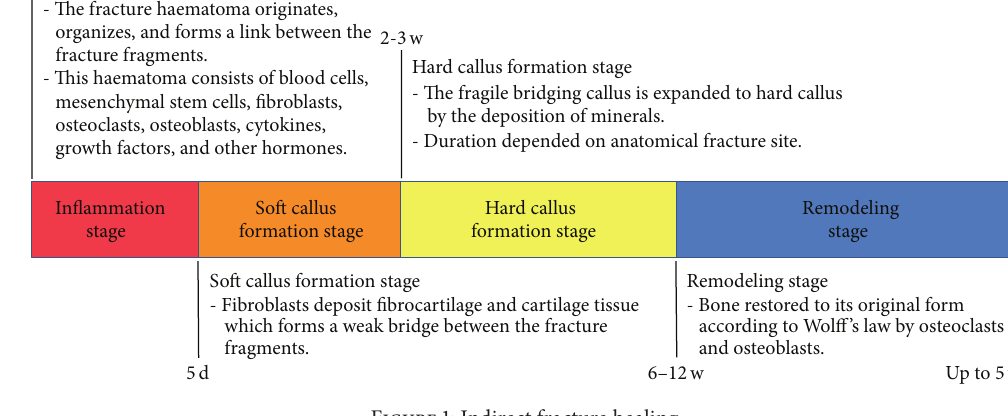
Figure 1: Indirect fracture